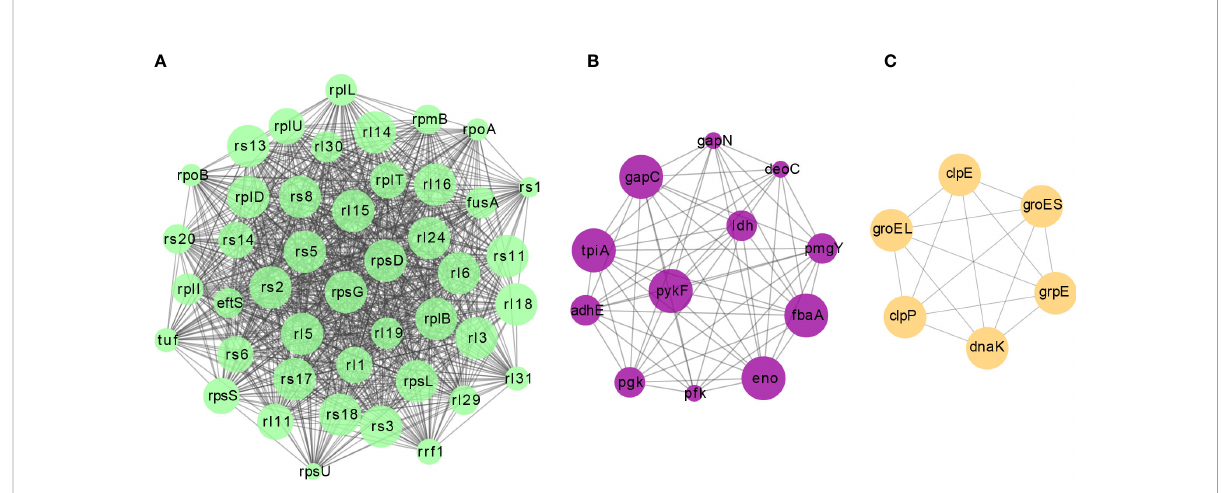
FIGURE 3 The top three clusters of highly interconnected malonylated PPI networks. Interaction network of lysine-lactylated proteins (listed in gene names) were analyzed using the MCODE plug-in toolkit in the Cytoscape software (version 3.7.2). (A) Cluster 1: MCODE score = 42.186, nodes = 44, edges = 907. (B) Cluster 2: MCODE score = 11.091, nodes = 12, edges = 61. (C) Cluster 3: MCODE score = 6, nodes = 6, edges =